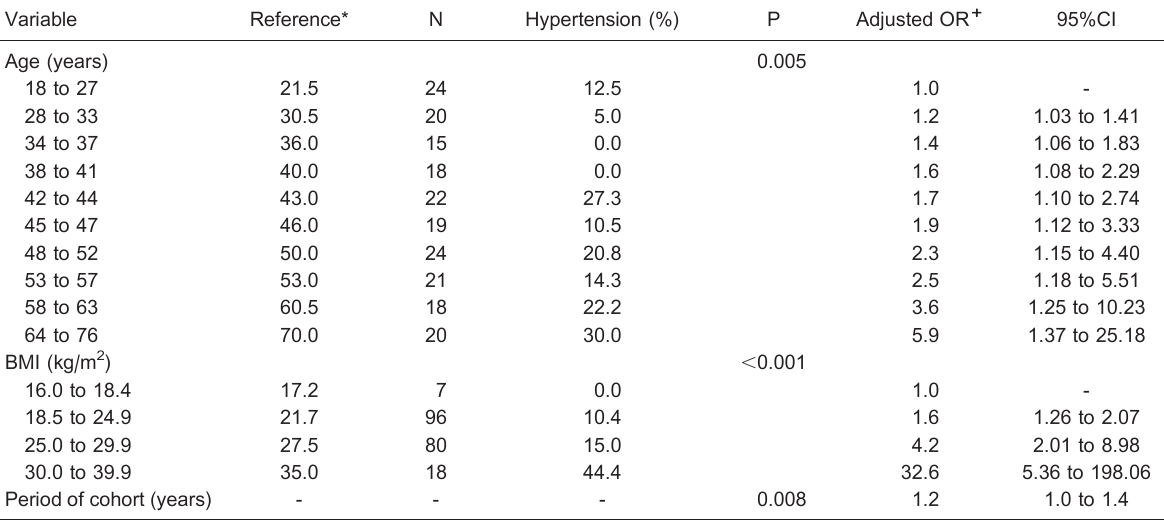
Table 4. Multivariate analysis of the association between risk factors, which remained in the model with a P value , 0.05, and hypertension.